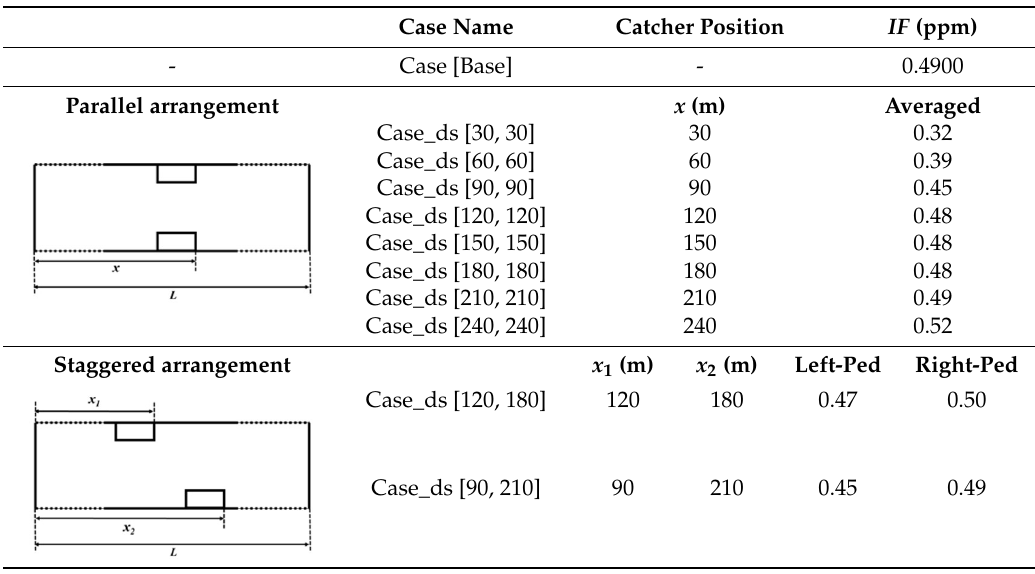
Table 7. Intake Fraction ( IF ) in cases with two short catchers.